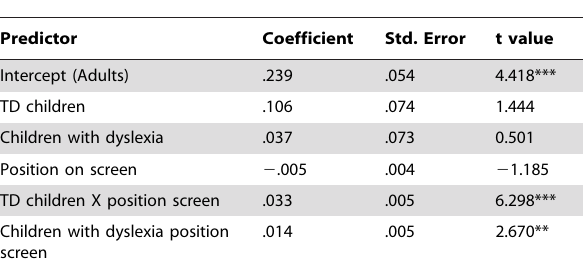
Table 2. Start of fixation disparity for all valid fixations during the dot scanning experiment: coefficients and standard errors are shown and the t-value with significance.